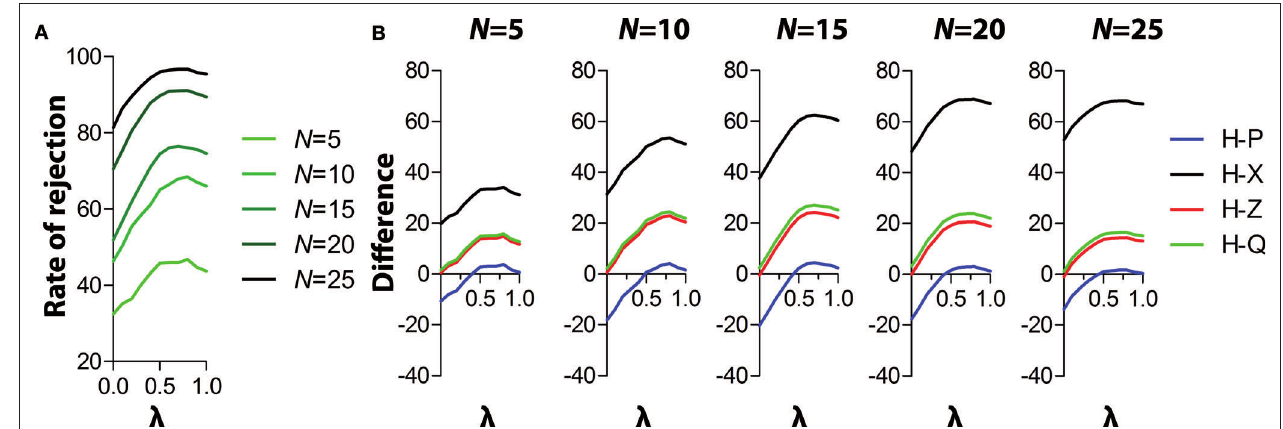
FIGURE 5 | Varying the weighting of H the null hypothesis are shown for different weights of H [1 − λ ], respectively) for different sample sizes (range 5–25). Hypothesis